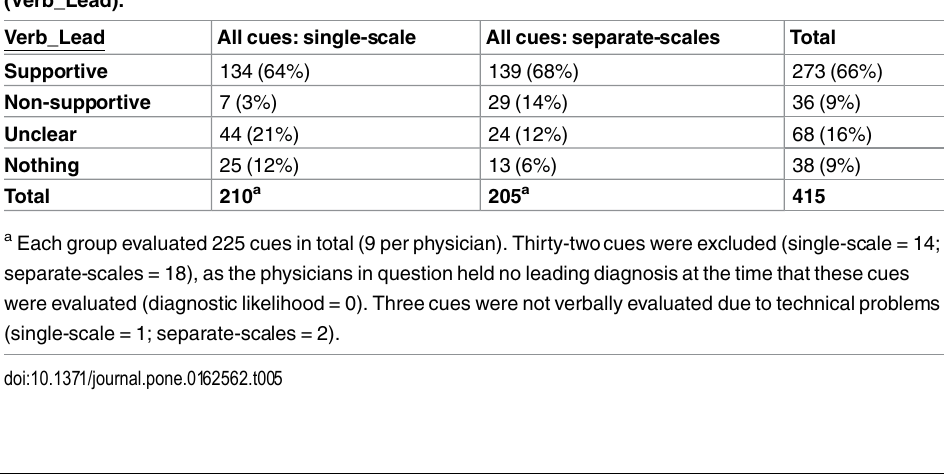
Table 5. Frequency and proportion of codesassignedto verbalizationsaboutthe leadingdiagnosis (Verb_Lead). Verb_Lead All cues: single-scale All cues: separate-scales Total Supportive 134 (64%) 139 (68%) 273 (66%)